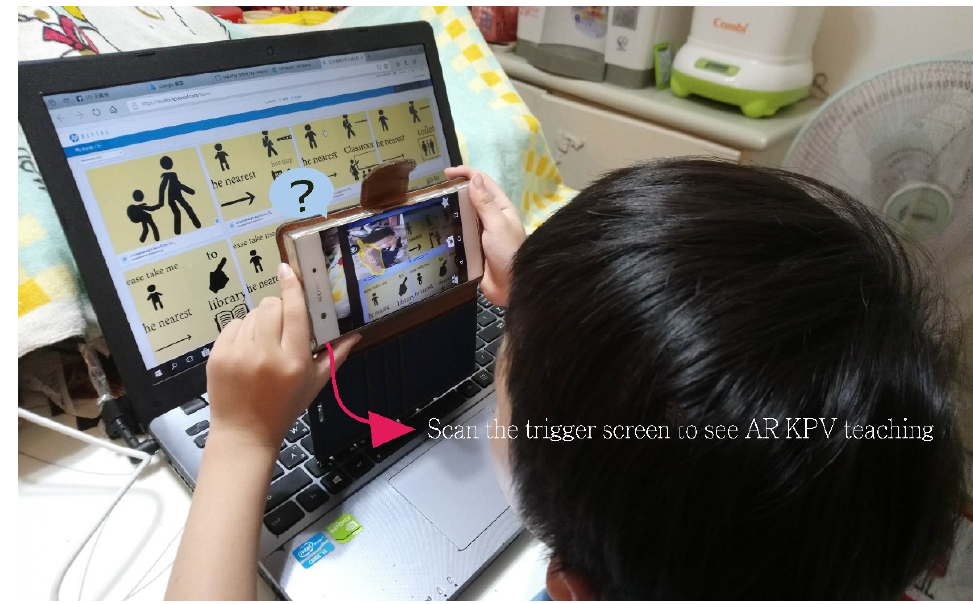
Figure 3. Example of KPV materials created from AR.